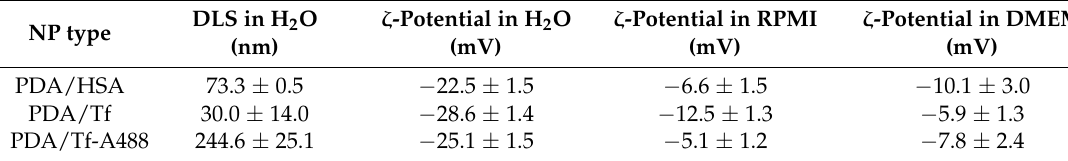
Table 1. Size and ζ -potential of the (PDA)/(has), PDA/Tf, and